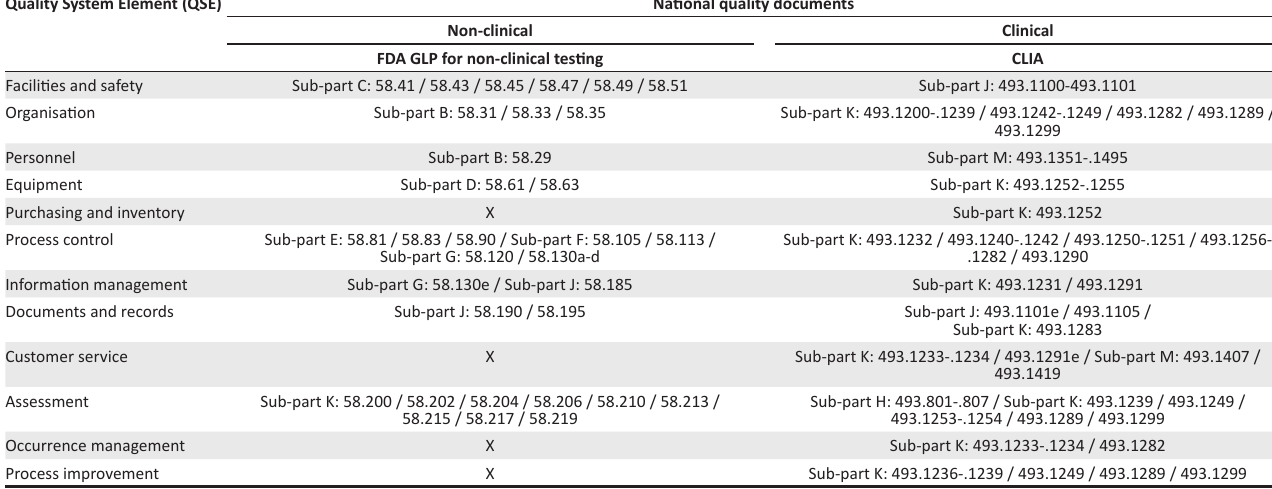
TABLE 2a: Analysis of contents of national quality documents using the Quality System Essentials framework. Quality System Element (QSE)